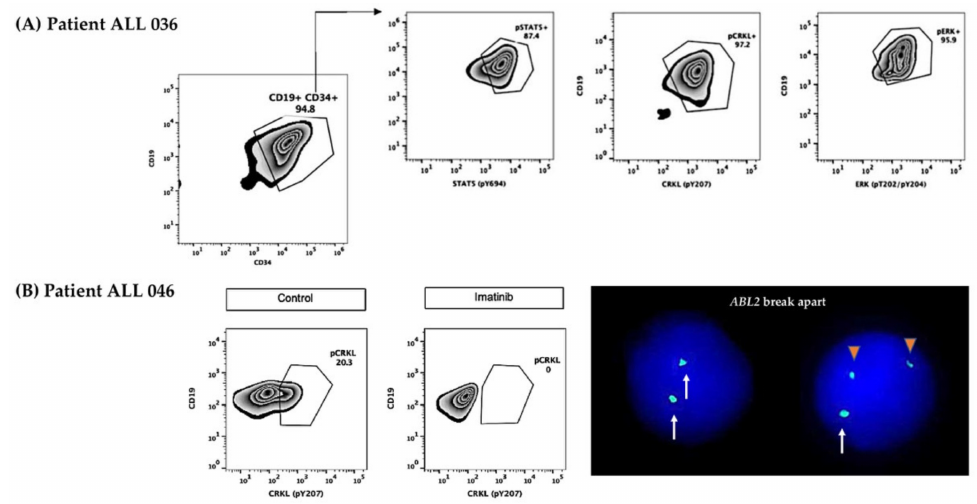
Figure 4. Two patients with signaling pathway activation. ( A ) Patient ALL 036 showing positivity to the three surrogate markers pStat5, pCrkl, and pErk. ( B ) Patient ALL 046 showing positivity to pCrkl and reversion produced by imatinib, and interphase nuclei hybridized with ABL2 break- apart FISH probe with a normal pattern (two large green signals in the left nucleus) and with an ABL2 breakage (one large green signal representing the normal gene, and two small green signals representing the broken gene in the rightright nucleus). White arrows represent the normal ABL2 loci and orange triangles represent the breakage of ABL2 .The Abl pathway was assessed in 29 patients and the surrogate marker pCrkl was positive in 10 (Figures 1 and 4A); of these, 7 patients presented a genetic abnormality involving CRLF2 , interestingly, 4 out of 7 cases were also positive for pStat5. On the other hand, three of the seven cases showed no evidence of abnormalities in CRLF2 and the GEPs were 3.3, 6.7, and 1.0. It was possible to analyze two patients positive to pCrkl (ALL 039 and ALL 046) with ABL1 and ABL2 break-apart FISH probes, positive results were obtained for ABL2 breakage in 16% and 6% of cells analyzed, respectively. Interestingly, patient ALL 046 was also found to be positive for IGH::CRLF2 and showed the presence of both surrogate markers pStat5 and pCrkl, revealing the coexistence of both abnormalities in the same patient. Remarkably, this case showed pCrkl reversion using imatinib (Figures 1 and